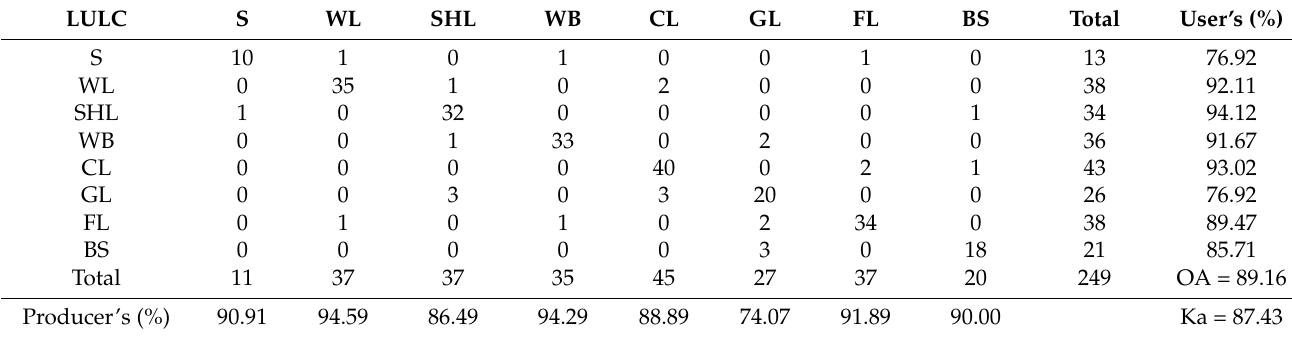
Table 10. Confusion matrix of LULC in 2018 (S: Settlement; WL: Water body; SHL: Shrub land; CL: Cultivated land; GL: Grassland; FL: Forest land; BS: Bare soil).